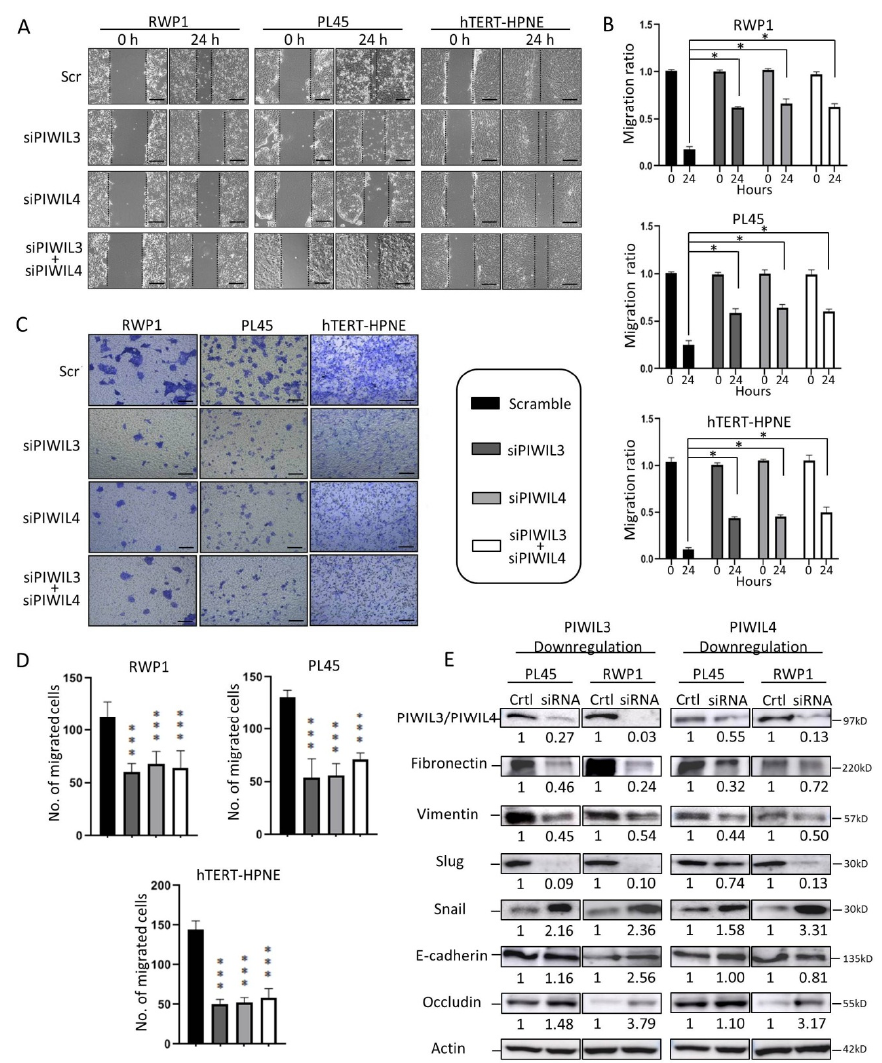
Figure 2. Downregulation of PIWIL3 and/or PIWIL4 decreased motility of PC and non-tumor cell lines through regulation of epithelial-to-mesenchymal transition (EMT). ( A ) Micrographs of wound healing assay showed reduced cell motility after PIWIL3 and/or PIWIL4 silencing in both PC-derived cell lines and in the non-tumor pancreatic-derived cell line. Representative images have been taken at 0 and 24 h after scratching. Broken lines indicate migration heads. ( B ) Statistical analyses of the motility ratio for each cell line according to PIWIL3 and/or PIWIL4 silencing. ( C ) Representative images from Boyden chamber assay of different cell lines taken at 24 h after seeding. ( D ) Statistical analyses of the number of migrated cells for each cell line according to PIWIL3 and/or PIWIL4 silencing. ( E ) Western blot for the expression of PIWIL3 (left) or PIWIL4 (right), Fibronectin, Vimentin, Slug, E-Cadherin and Occludin in PL45 and RWP1 after PIWIL3 or PIWIL4 silencing. The ratio of each protein/Actin ratio is represented under each protein band. Color-coding for each protein downregulation is indicated in the legend box. kDa: kilodalton. Scale bar: 50 µm. * p < 0.05; *** p < 0.001.